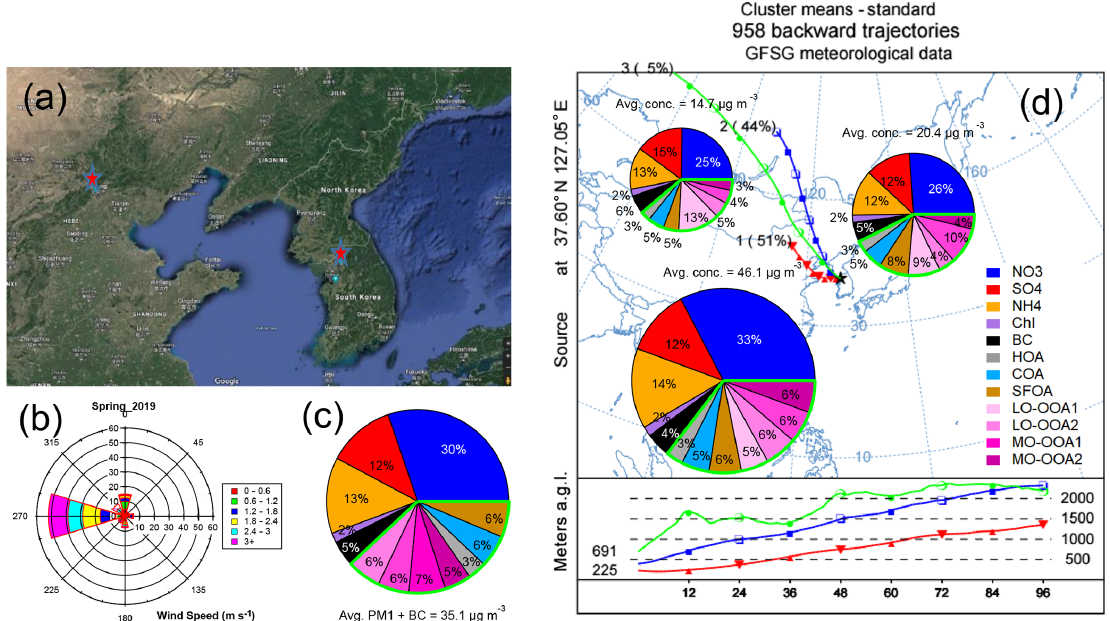
Figure 1. (a) © Google map of the measurement sites in the SMA in South Korea and Beijing in China; (b) wind rose plot for the entire study period; (c) average compositional pie chart of the PM 1 species and each of the factors of the OA during the whole campaign. The green outline indicates the fraction of the total OA; (d) averaged compositional pie chart of the PM 1 species (nonrefractory-PM 1 plus black carbon (BC)) in the three different HYSPLIT clusters. The trajectories were released at half of the mixing height at the KIST site (37.60 ◦ N, 127.05 ◦ E; latitude, longitude) during the entire